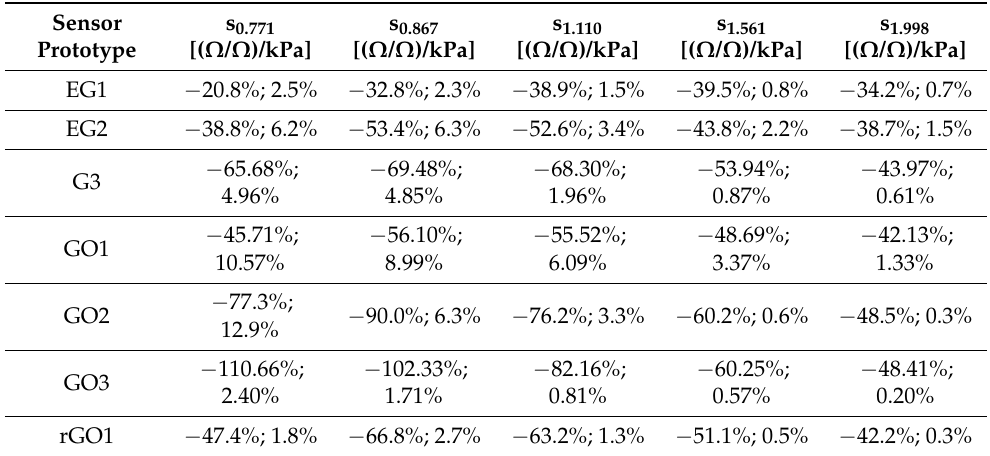
Table 2. Relative sensitivity, s , of sensor prototypes and their respective standard